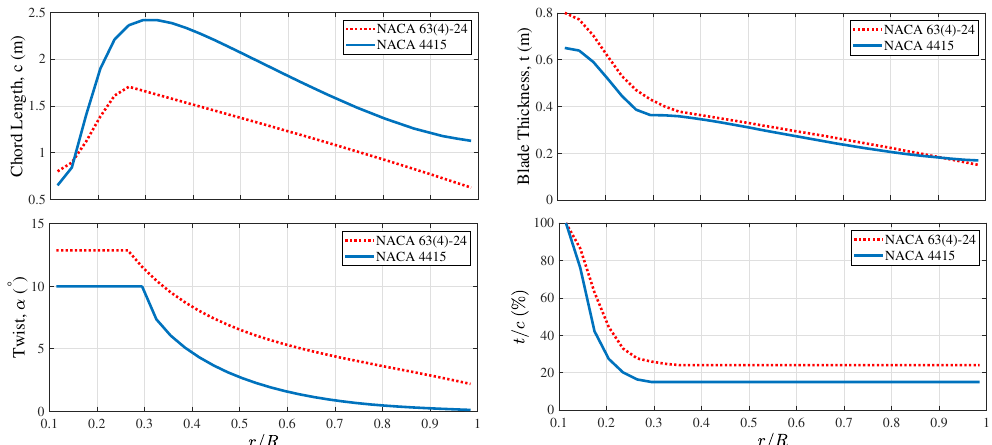
Figure 4. Comparison between full-scale blade geometric characteristics for the original RM1 blade design (NACA-63(4)-24) and the modified design (NACA-4415) for lower Reynolds number testing at